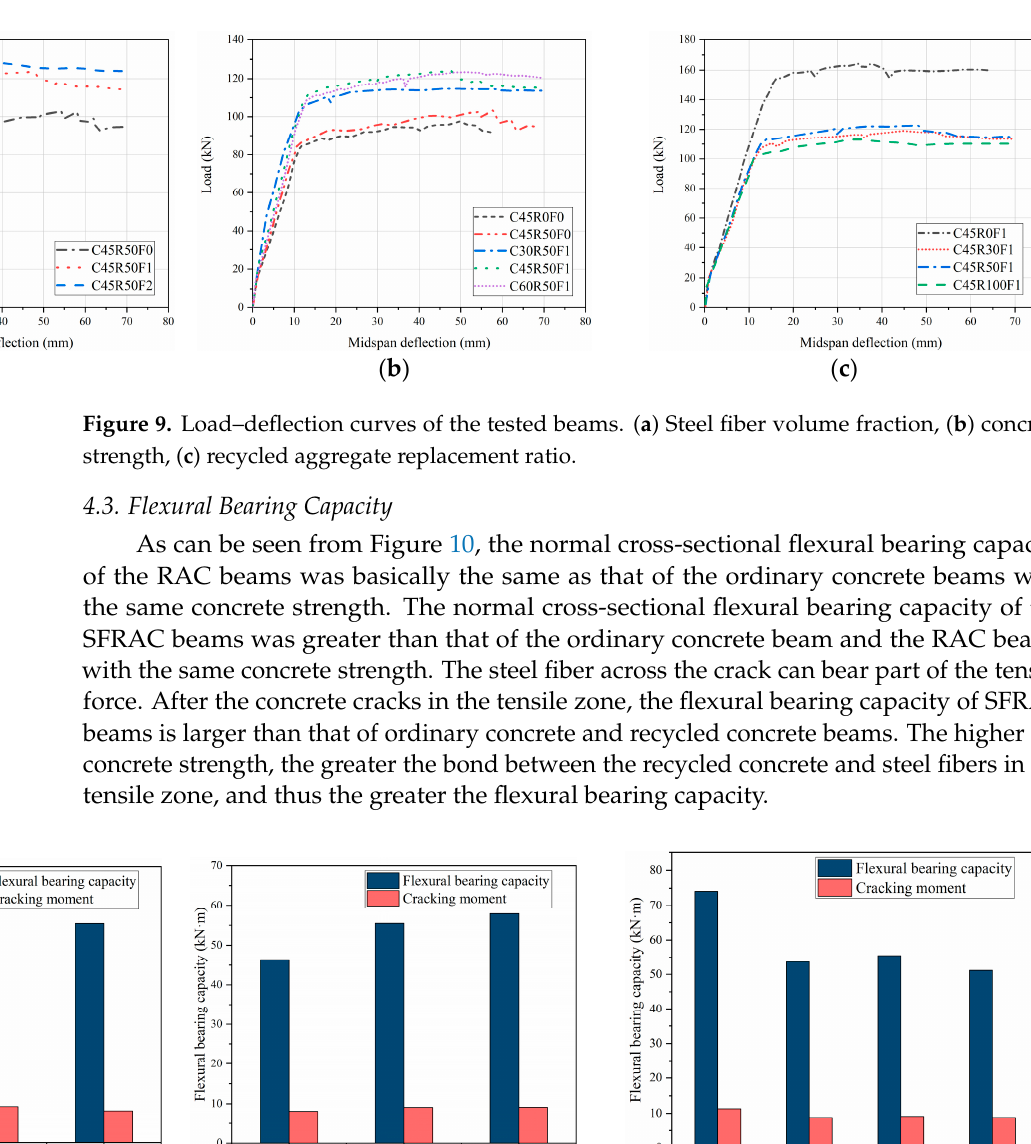
Figure 8. Three stages of beam force and deformation. ( a ) The elastic stage, ( b ) the working stage with cracks, ( c ) the damage stage.